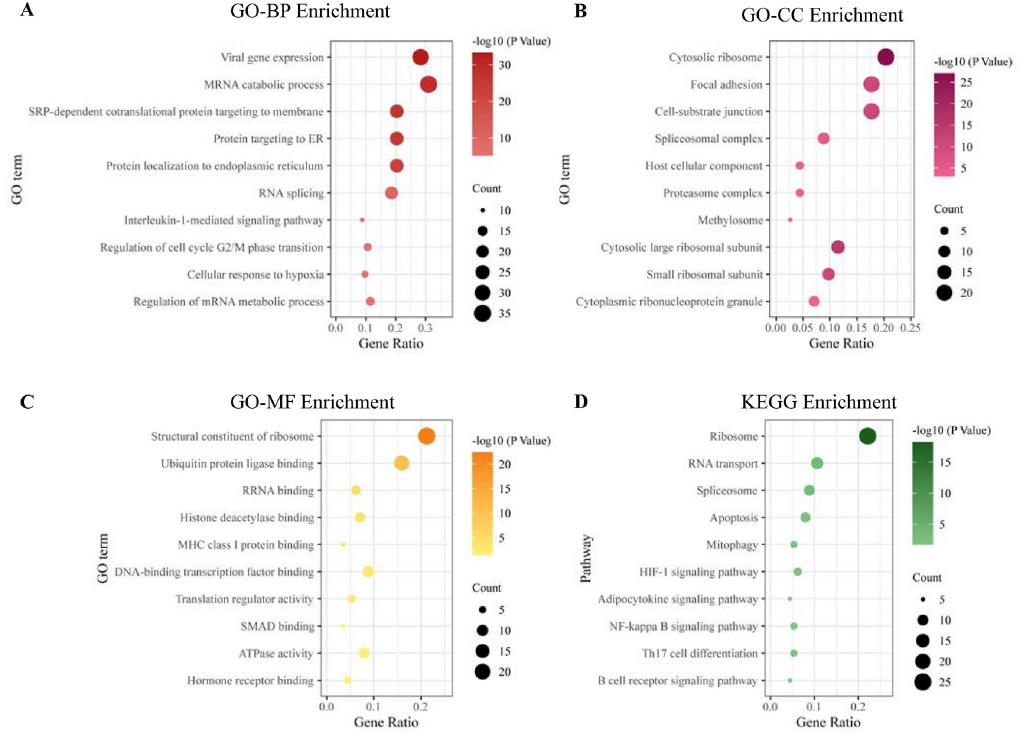
Fig 5. Functional enrichment analysis of hub genes. (A-C) Gene ontology enrichment analysis. (D) Kyoto Encyclopedia of Genes and Genomes pathway enrichment analysis. BP, biological process; CC, cellular component, MF, molecular function.